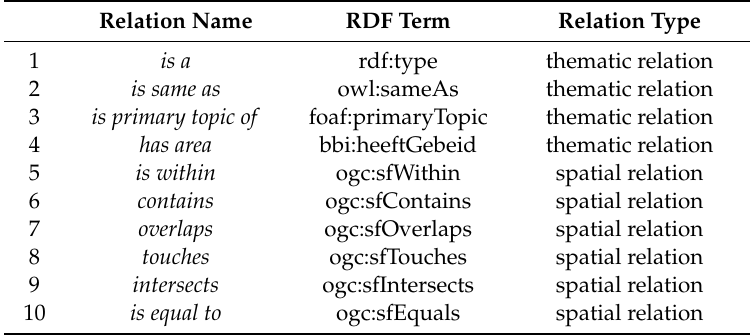
Table 5. Relations between concepts of KKG and their types. (Source: